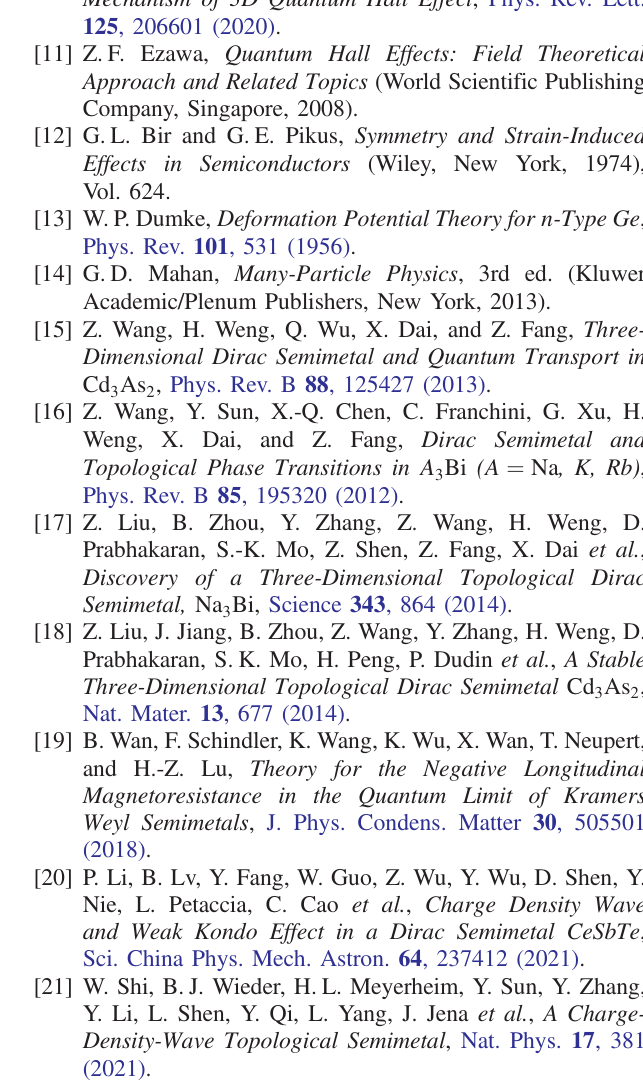
− 2 . 7 × 10 − 3 ℏ , − 1 . 5 × 10 − 3 ℏ , and − 1 . 47 × 10 − 4 ℏ , respec-